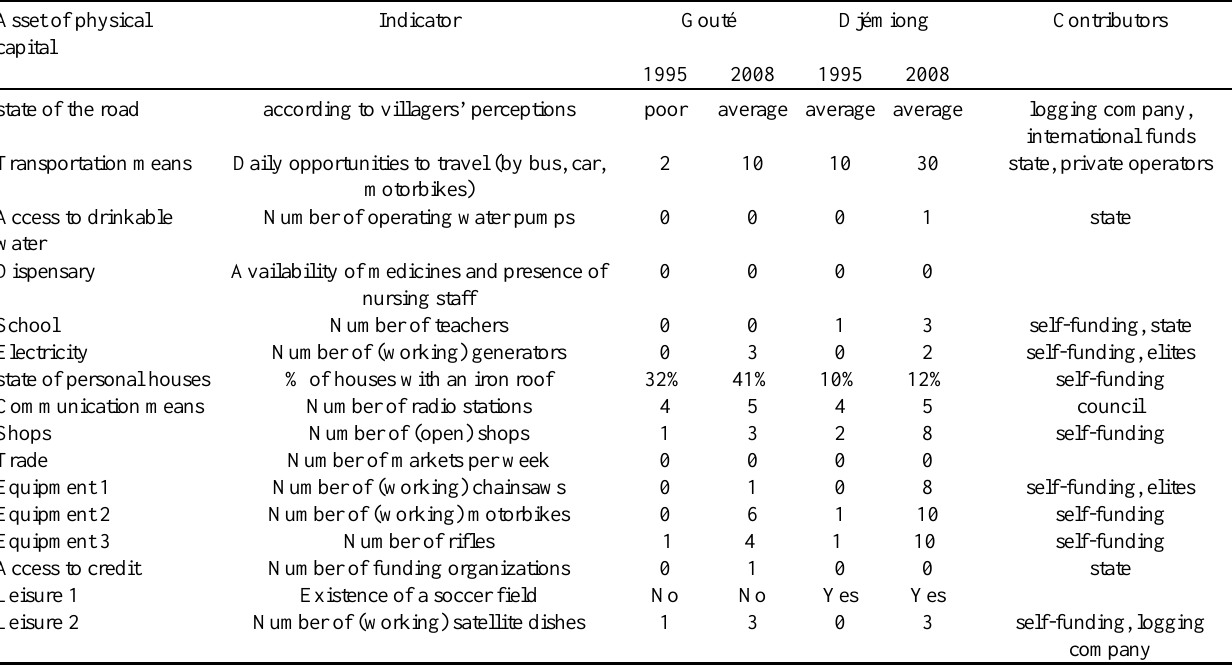
Table 2 . Evolution of the physical capital in the two sampled